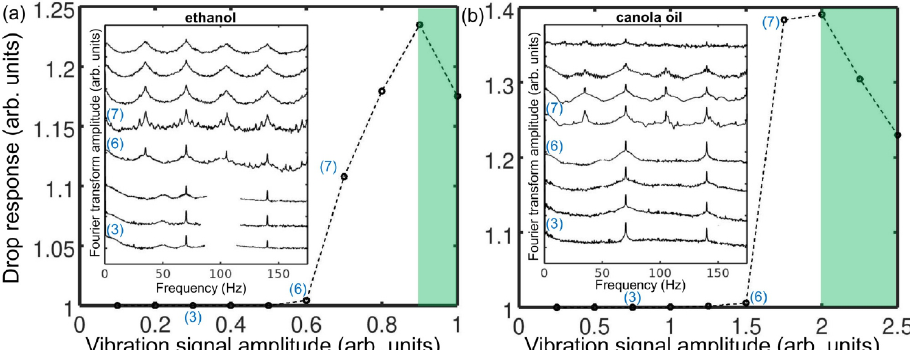
Figure 19. ( a ) Experimental average response of an ethanol drop subjected to vertical vibration at 70Hz plotted as a function of the vibration amplitude. The inset shows the power spectra obtained by Fourier-transforming the measured signals. The parenthetical labels relate the spectra to the experimental points in the main panel. ( b ) Experimental average response of a canola oil drop sub- jected to vertical vibration at 70Hz plotted as a function of the vibration amplitude. The modulation sidebands (the spectrum label 7) are present in the ethanol drop spectra and absent in the spectra of a canola oil drop. The shaded regions in the main panels correspond to the chaotic oscillations, resulting in strong diffuse scattering leading to a decrease in the optical intensity of the detected signal. Reproduced from [23]. Copyright 2019 by the American Physical